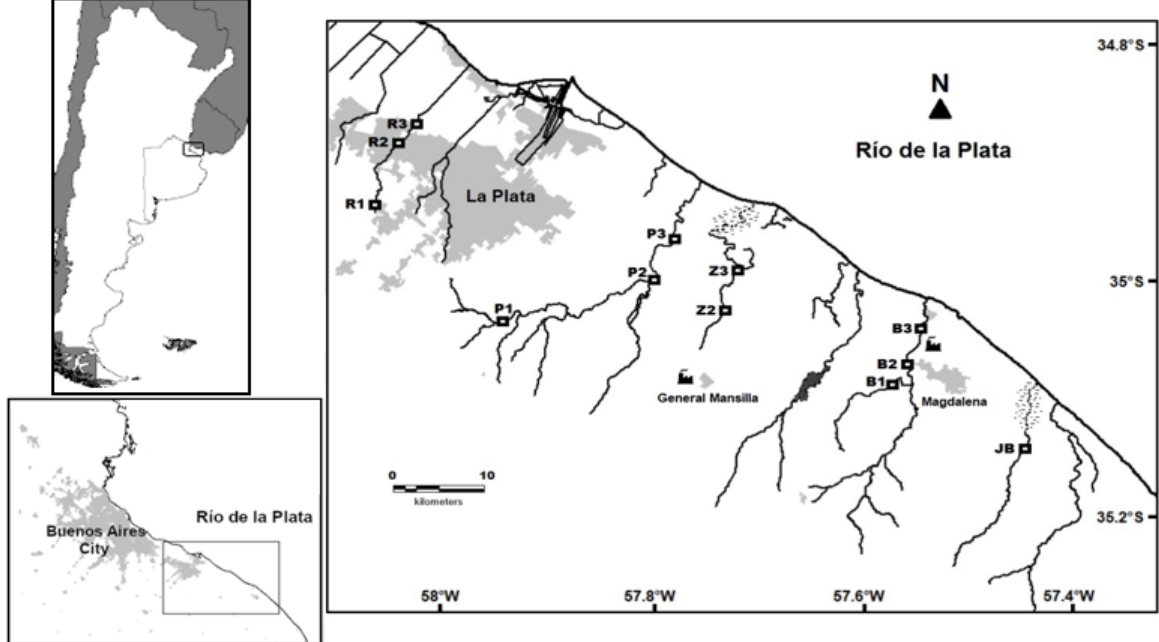
Figure 1. Study sites in pampean streams, Buenos Aires province, Argentina. R1-R3: Rodríguez, P1-P3: Pescado, Z2 and Z3: Zapata, B1-B3: Buñirigo, JB: Juan